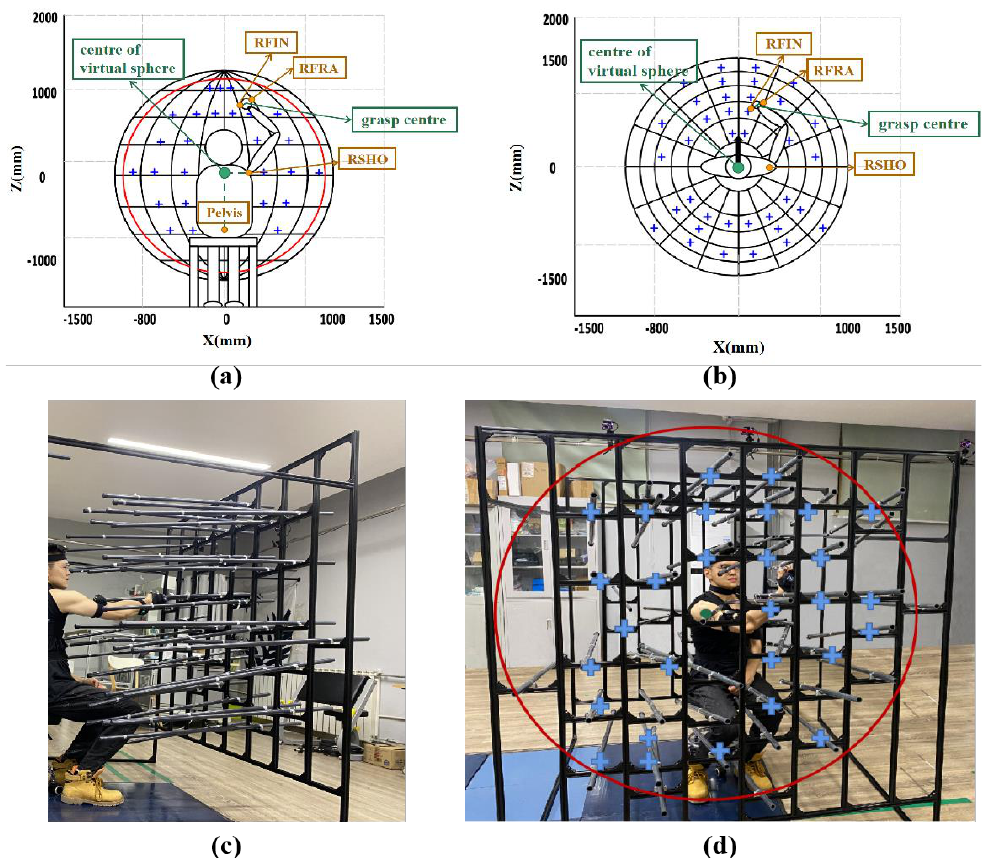
Figure 2. ( a , b ) the spherical workspace in the top and forward views, respectively. ( c , d ) The participant is reaching; the person permitted the use of this image.